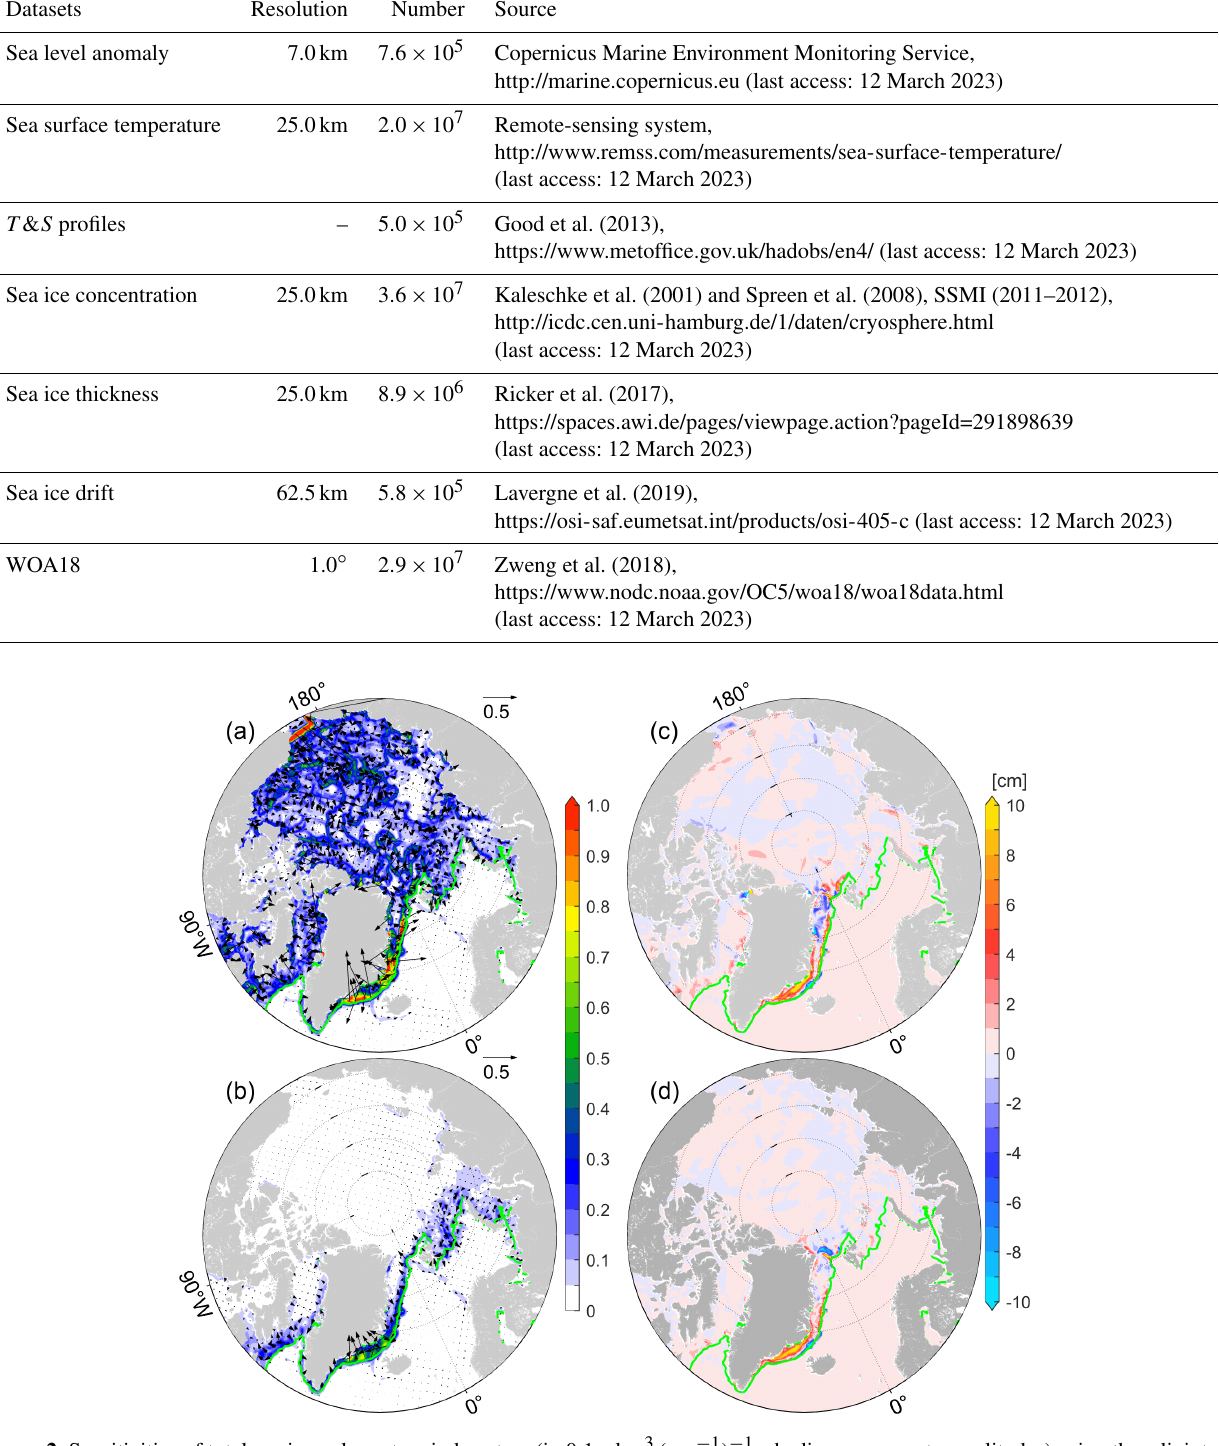
Table 1. Assimilated measurements.